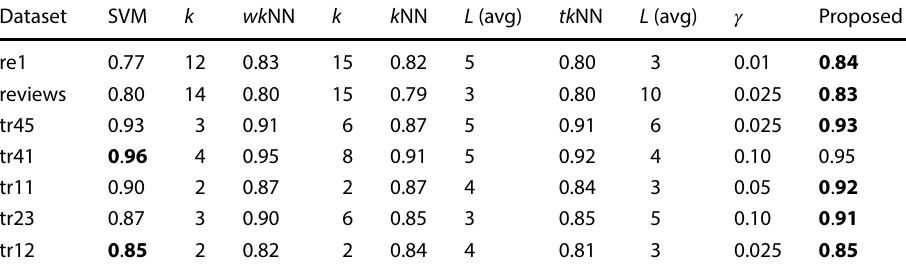
Bold value indicates the best performance (i.e., the highest value) in each